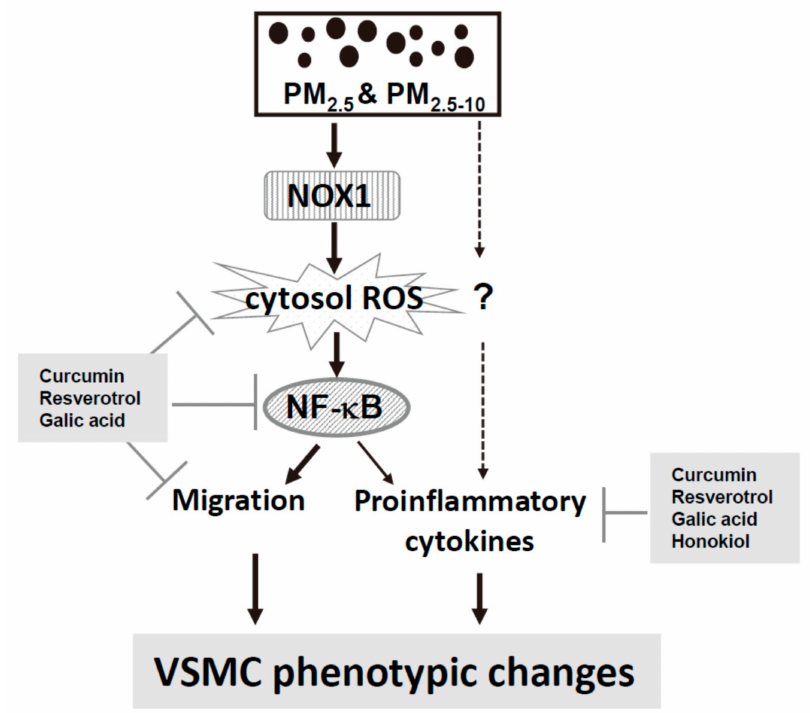
Figure 10. Summary of the mechanisms through which phenotypic changes in MVSMCs was induced by PM 2.5 and PM 2.5-10 and prevented by polyphenolic